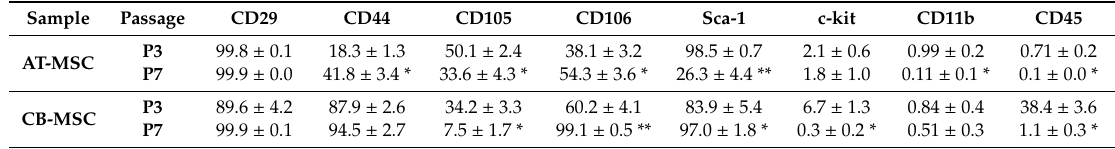
Table 1. Percentage of cell populations in AT-MSC and